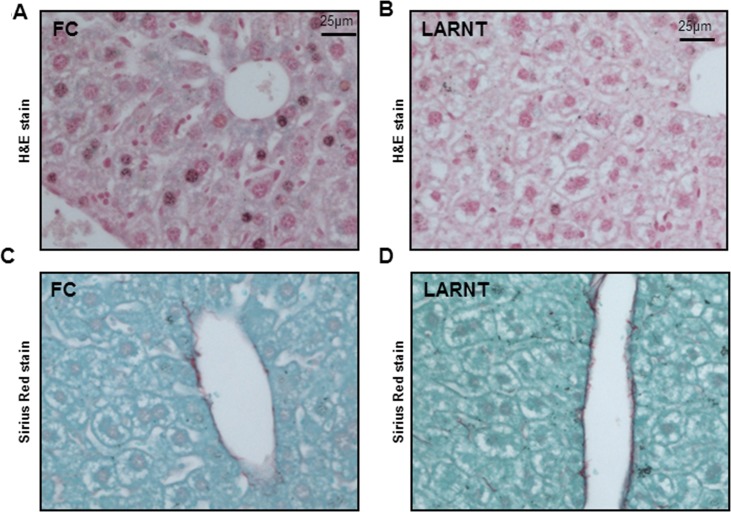
Haematoxylin and Eosin staining of liver sections from fasted floxed control (FC) mice (A) and LARNT (B) mice. Sirius Red staining from FC (C) and LARNT (D) mice.